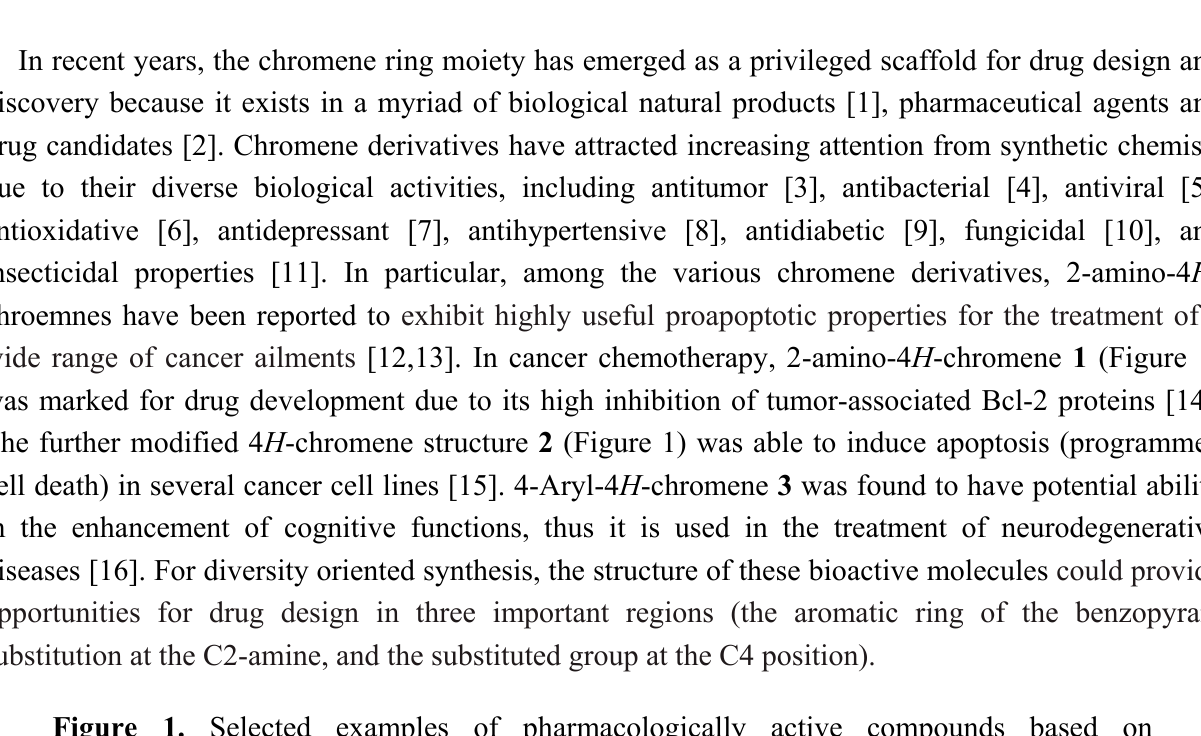
1. Selected examples of pharmacologically active compounds based on 4 H -chromene